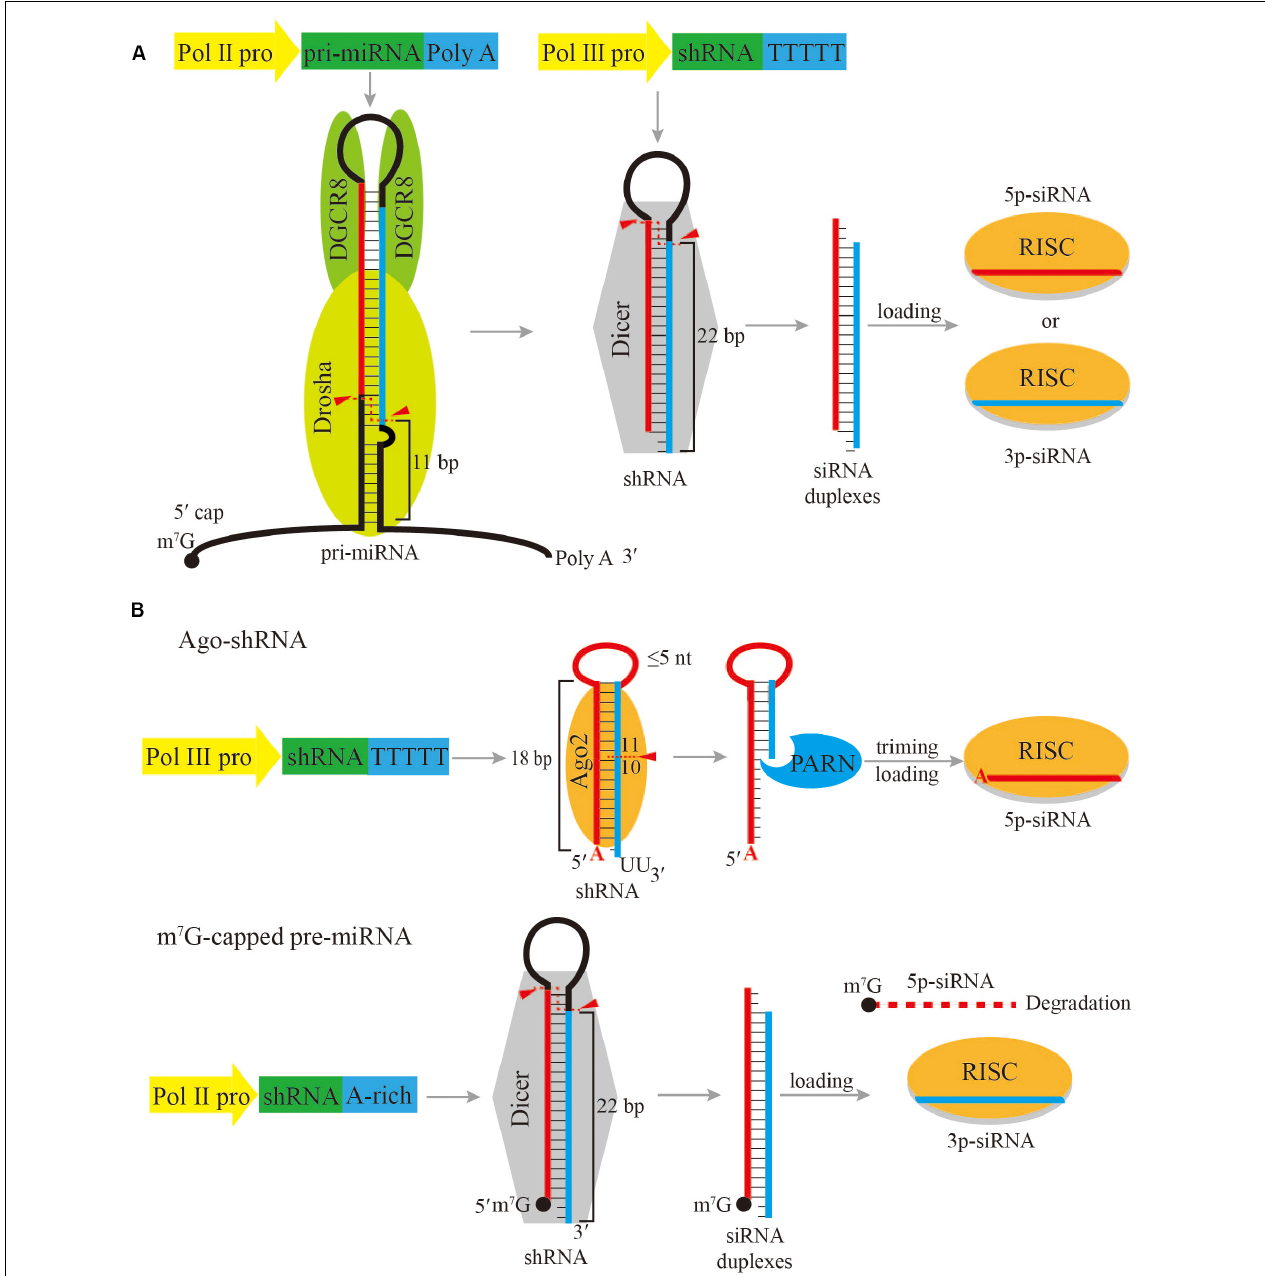
FIGURE 1 | Schematic of shRNA expression cassettes and processing pathways. (A) Common shRNA expression cassettes driven by a Pol II promoter or a Pol III promoter, and the subsequent processing pathway. (B) Ago-shRNA and m 7 G-capped pre-miRNA expression cassettes and processing pathways. Ago-shRNA is cleaved by Ago2 and subsequently trimmed by PARN. The 5p-siRNA is loaded into RISC. m 7 G-capped pre-miRNA is cleaved by Dicer and the 3p-siRNA is loaded into RISC. Triangles indicate cleavage